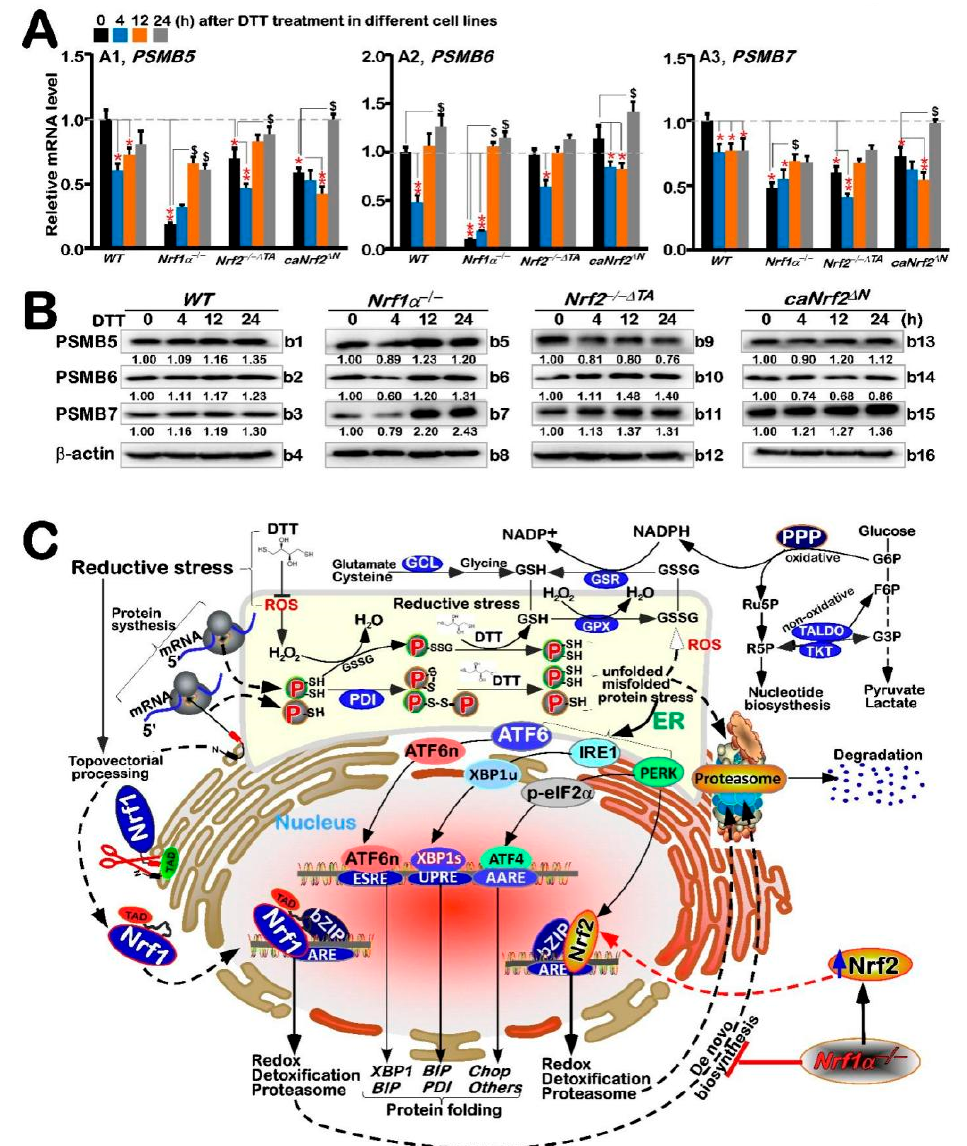
Figure 6. Differential expression of proteasomal genes regulated by Nrf1-independent pathway under reductive stress induced by DTT. ( A ) Four genotypic cell lines of WT , Nrf1 α − / − , Nrf2 − / −(cid:52) TA and caNrf2 (cid:52) N were (or were not) treated with 1 mM DTT for 0 to 24 h, before both basal and DTT- inducible mRNA expression levels of core proteasomal subunit genes (i.e., PSMB5 ( A1 ), PSMB6 ( A2 ) and PSMB7 ( A3 )) were determined by RT-qPCR. The resulting data were shown as fold changes ( mean ± SD , n = 3 × 3 ), which are representative of at least three independent experiments, each performed in triplicate. Significant increases ( $ , p < 0.05 ) and significant decreases ( * p < 0.05 ; ** p < 0.01 ) were statistically calculated by comparison with their corresponding controls (measured at 0 h). ( B ) These proteasomal protein expression levels in four distinct cell lines were determined by Western blotting with their indicated antibodies, such PSMB5 ( b1 , b5 , b9 , b13 ), PSMB6 ( b2 , b6 , b10 , b14 ) and PSMB 7 ( b3 , b7 , b11 , b15 ), whilst β -actin served as a loading control. The intensity of those immunoblots, representing different protein expression levels, was also quantified by the Quantity One 4.6.2 software, as shown on bottom ( C ). A model was proposed to provide a better explanation of distinct roles for Nrf1 and Nrf2 in DTT-stimulated reductive stress response, along with ER stress signaling and relevant redox